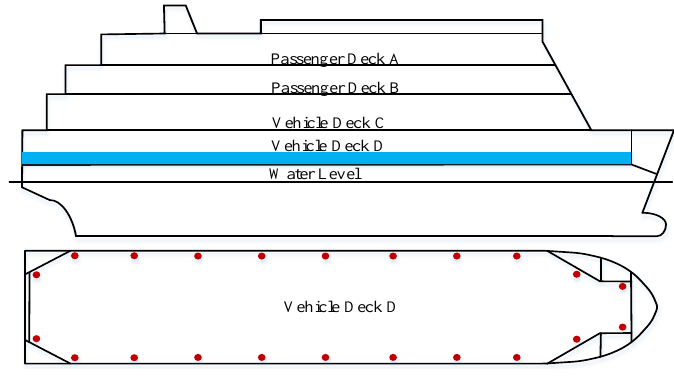
Figure 2. Arrangement of the scuppers on vehicle deck D.